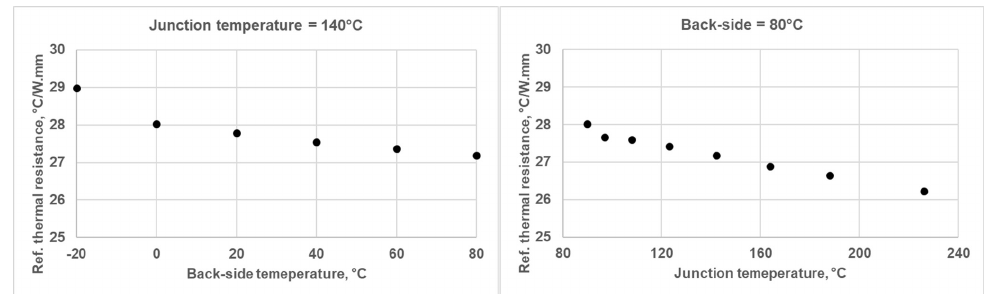
Figure 3. R th,REF extraction from 3D thermal simulations as a function of back-side temperature and junction